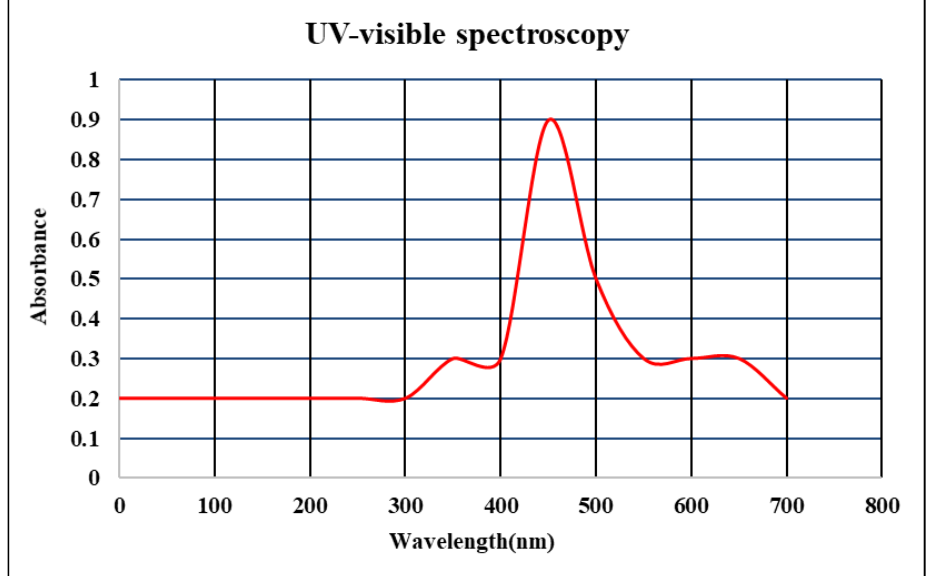
Figure 2. Confirmation of silver nanoparticles synthesis by UV-visible spectroscopy.